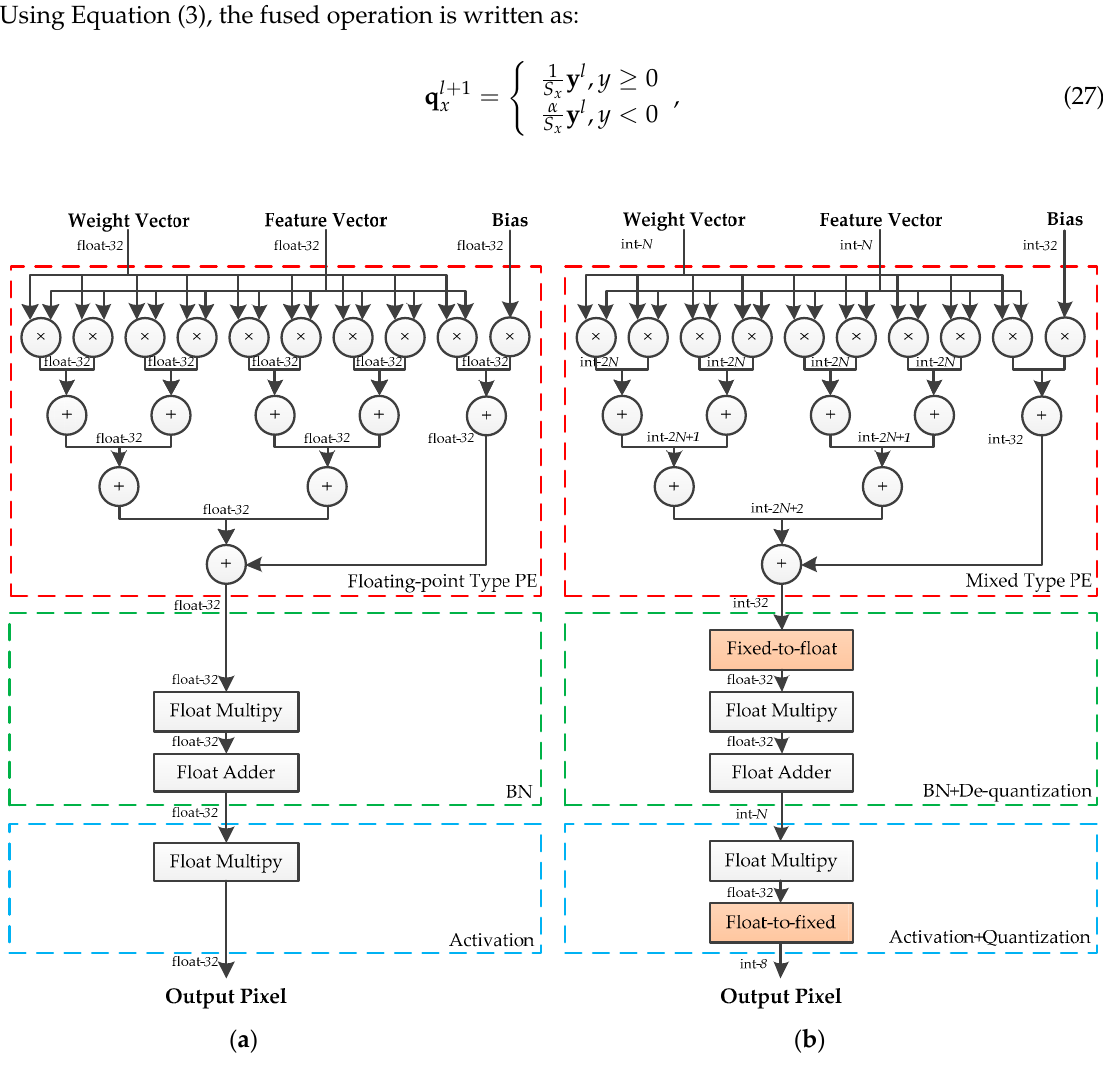
Figure 7. ( a ) Structure of the fused-layer floating-point-type PE. ( b ) Structure of fused-layer hybrid-type PE.